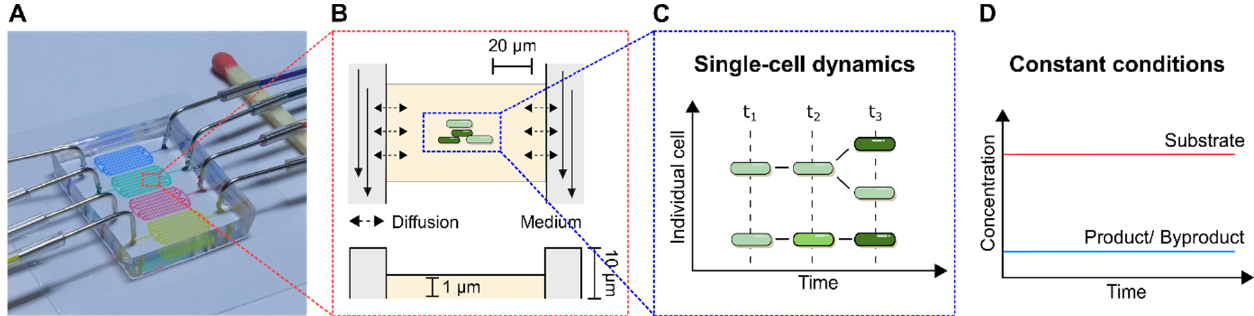
Figure 4. Microfluidic single-cell cultivation (MSCC) and its characteristics. ( A ) Microfluidic PDMS-glass cultivation device. ( B ) Schematic figure of a 2D cultivation chamber with its dimensions and characteristic flow profile. ( C ) Analysis of single-cell dynamics investigating growth-related and morphological heterogeneities. ( D ) Nutrient profile inside a 2D cultivation chamber during MSCC.